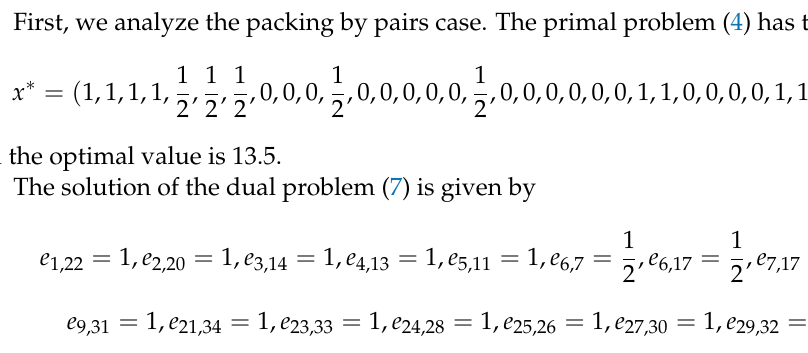
Figure 14. Packing by pairs for Zachary’s karate club